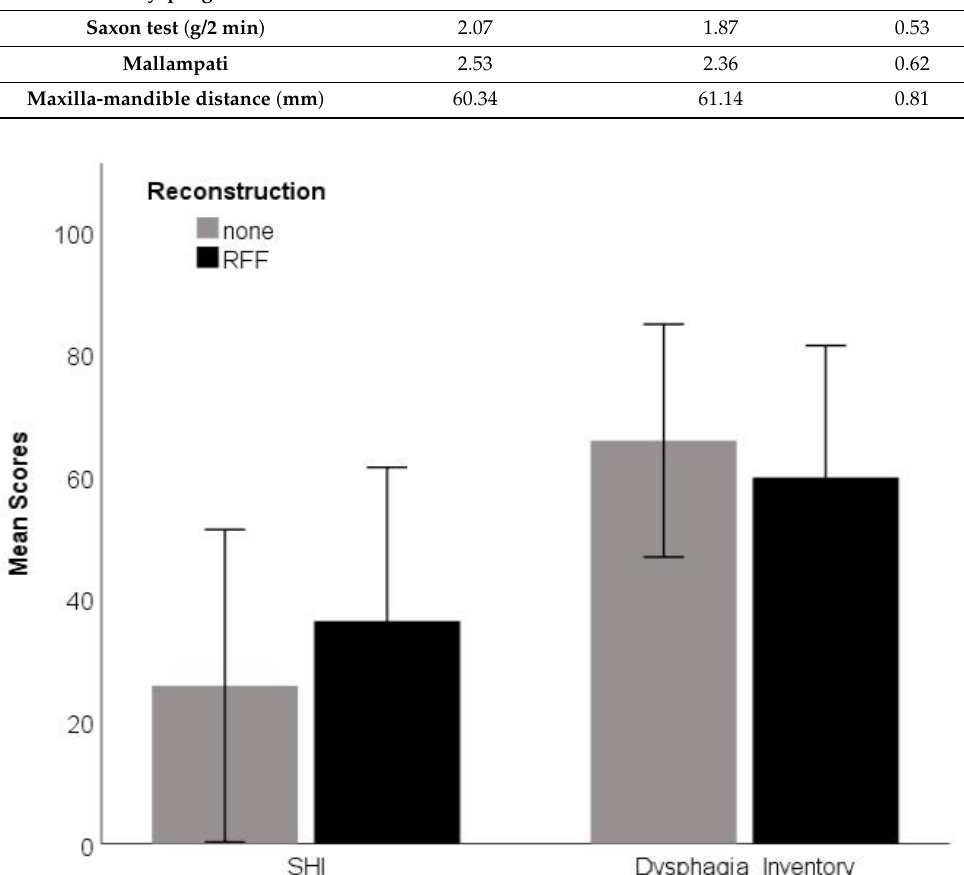
Figure 3. Results of the Speech Handicap Index (SHI) and the MD Anderson Dysphagia Inventory (MDADI) compared. A low symptom score in the SHI represents fewer problems with speech. A low score in the MDADI indicates greater difficulties in swallowing function. Table 7. Functional analyses.